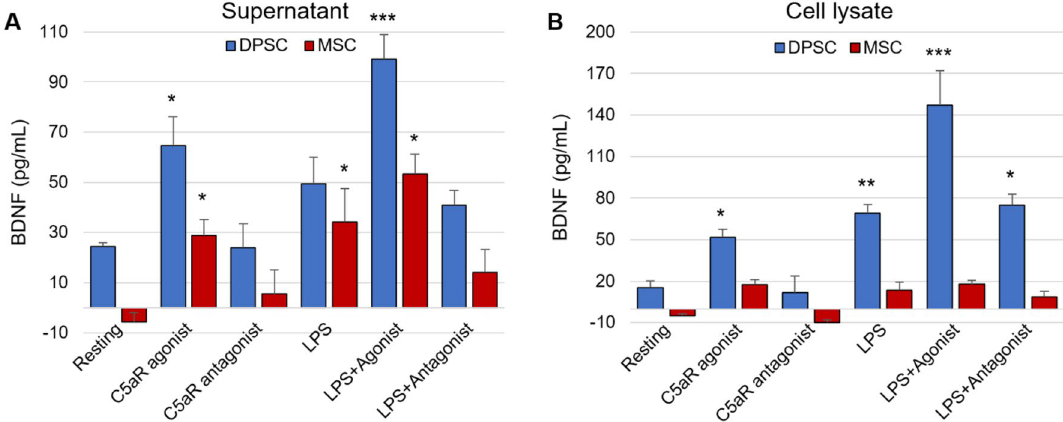
Figure 5. DPSCs produce higher levels of BDNF than BM-MSCs. BDNF in supernatants ( A ) and cell lysate ( B ) was measured by enzyme-linked immunosorbent assay after 48 h of treatment. For each experiment/ condition, the BDNF quantity was normalized to cell viability. Stimulation with C5aR-agonist or co-stimulation with LPS significantly increased the BDNF secretion in supernatants of DPSCs compared to BM-MSCs. BDNF secretion in the cell lysate of DPSCs was also significantly higher than BM-MSCs cell lysate. * p < 0.05, ** p < 0.01 and *** p < 0.001 versus untreated control of resting cells (n =